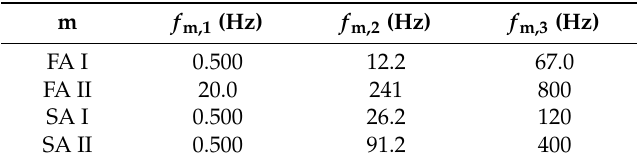
Table 1. The effective frequency range for each mechanoreceptive